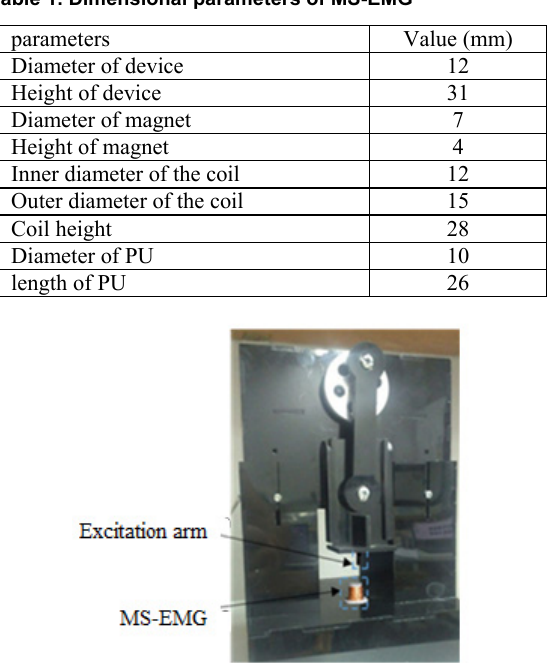
Figure 2. Fabricated Instrument for applying impact forces to MS-EMG